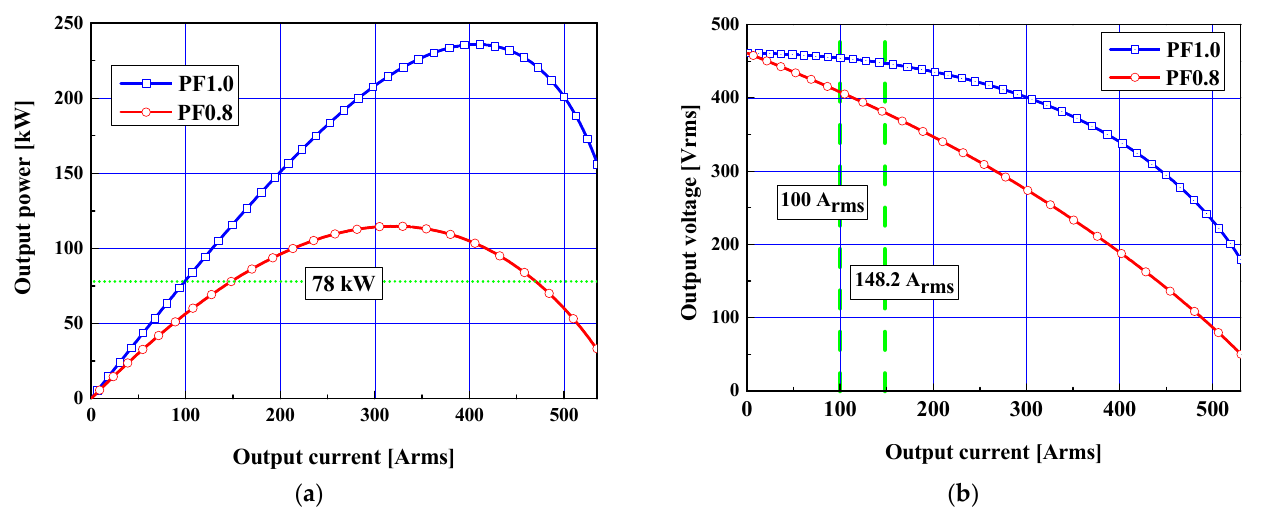
Figure 16. Output characteristics for the final design: ( a ) output power according to the output current, and ( b ) output voltage according to the output current. Table 5. Analysis results of load drive with 1800 rpm and 78 kW.